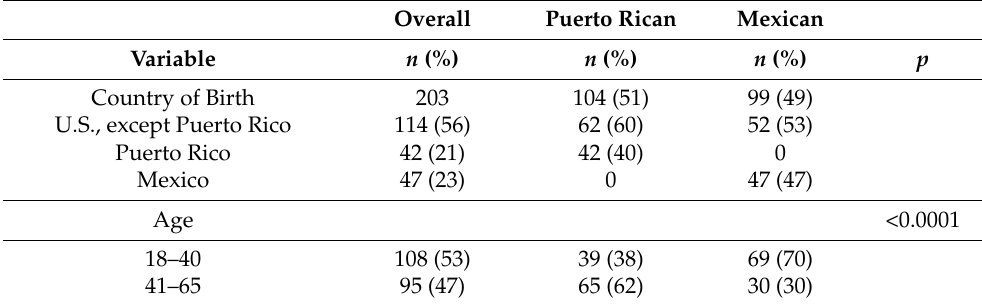
Table 1. Characteristics of Latino